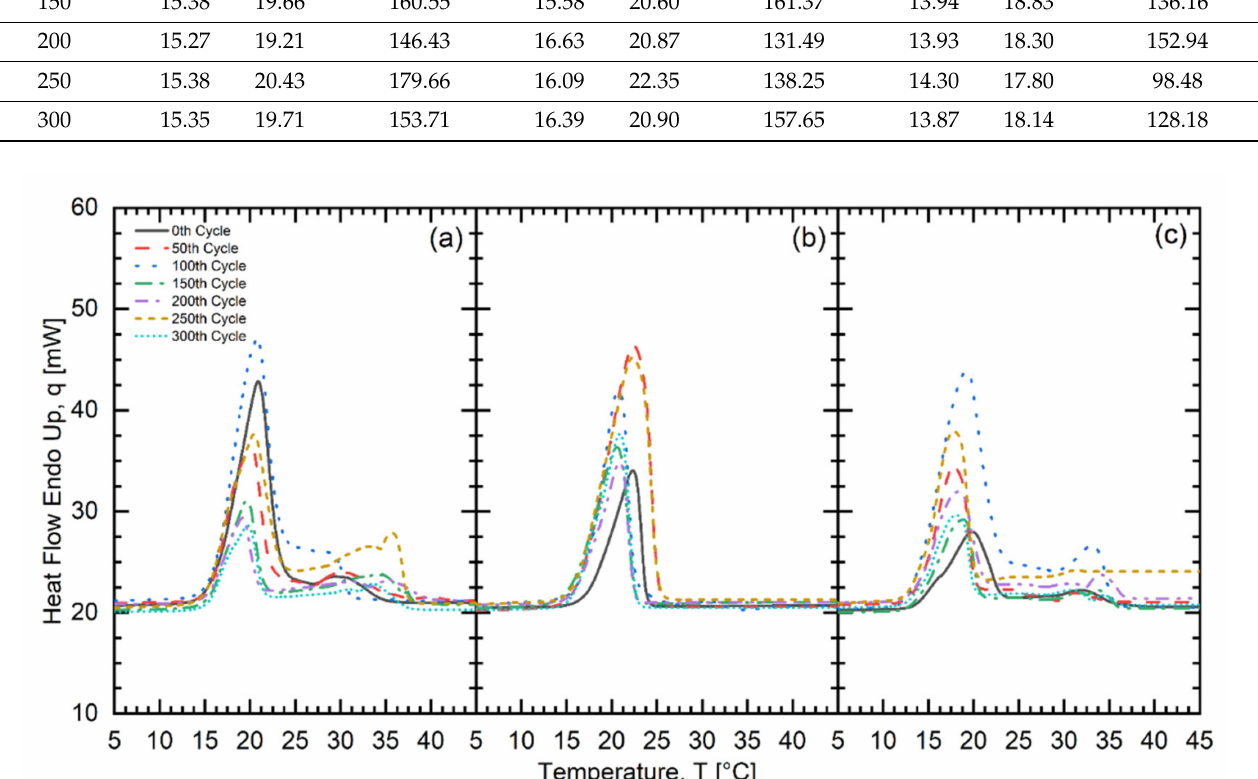
Figure 5. Cycle testing ( a ) CMS502525 ( b ) CMP701515 ( c )